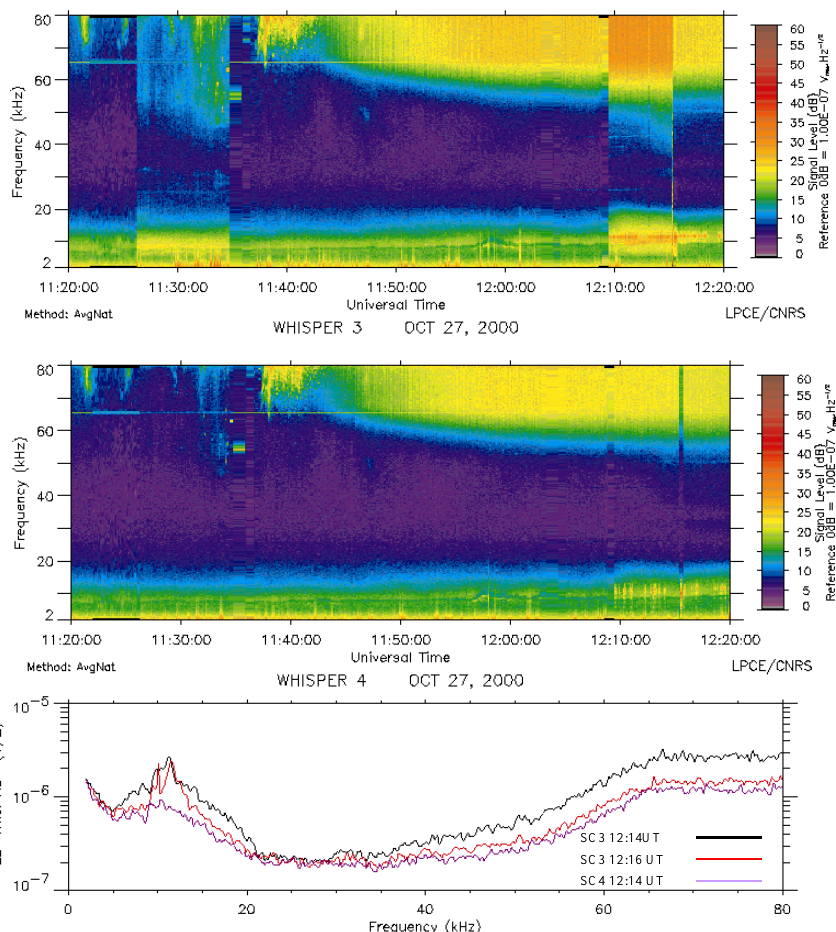
Fig. 3. Comparison of the potential difference measured on double sphere dipoles at three different sphere-to-sphere lengths: 46 m (most of the time) and 88 m (a few minutes centered at 11:30 and 12:12 UT) on SAMBA (SC3, upper panel); 36 m on TANGO (SC4, middle panel). The bottom panel displays single spectra measured at nearly the same time and place. The potential differences measured are proportional to the dipole length for the type III solar burst emissions (after 11:40 UT, above 40